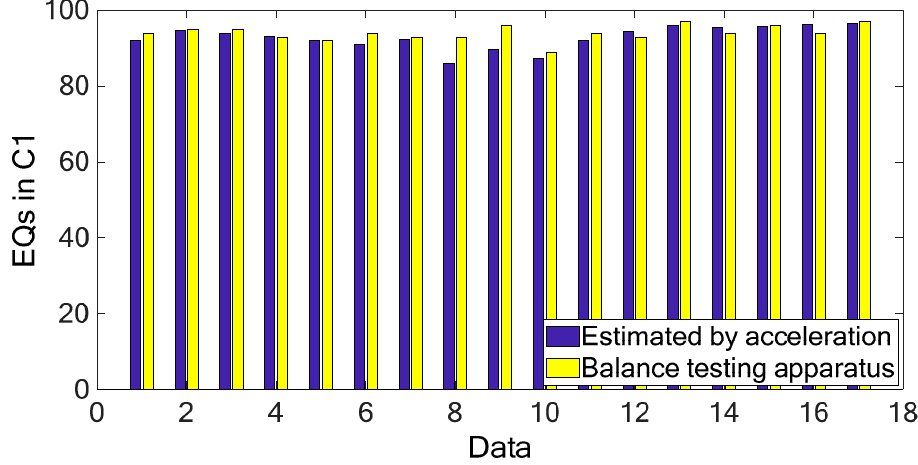
Figure 13. Flow chart of acceleration signal processing in estimating the EQs values.